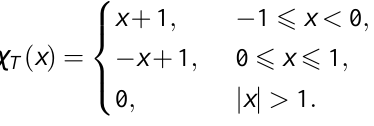
Fig. 2. Gauss set